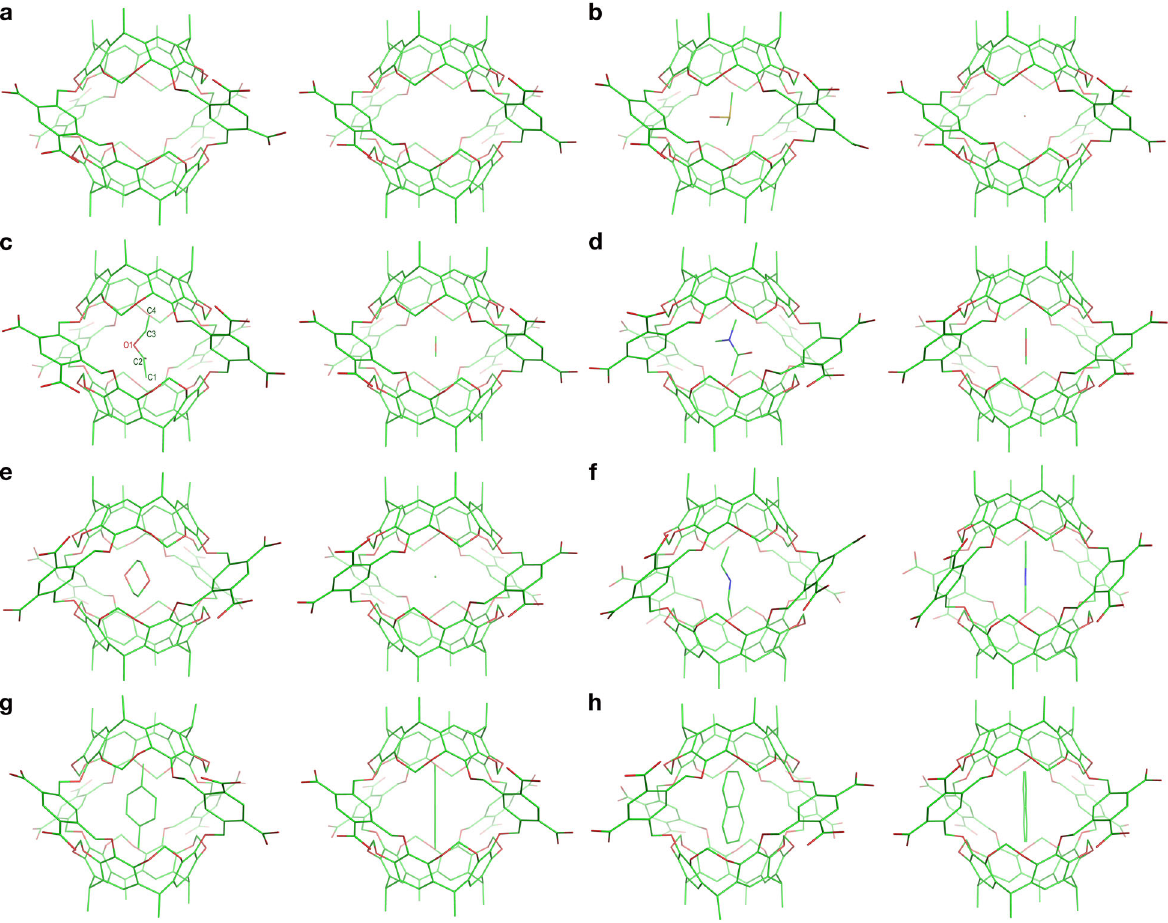
Fig. 6 The most populated conformations of Octacid4 and its complexes in the MD simulations at 298 K. a Octacid4. b DMSO (cid:129) Octacid4. c EtOAc (cid:129) Octacid4. d DMA (cid:129) Octacid4. e 1,4-Dioxane (cid:129) Octacid4. f DEA (cid:129) Octacid4. g p -Xylene (cid:129) Octacid4. h Naphthalene (cid:129) Octacid4. The representative and average conformations in the largest conformation cluster of a set of 20 MD simulations for each complex are shown in the left and right panels, respectively. No energy minimization was performed on these representative and average conformations. The sulfur, oxygen, nitrogen, and carbon atoms are in yellow, red, blue, and green, respectively. Hydrogen atoms, counter ions and water molecules are not displayed for